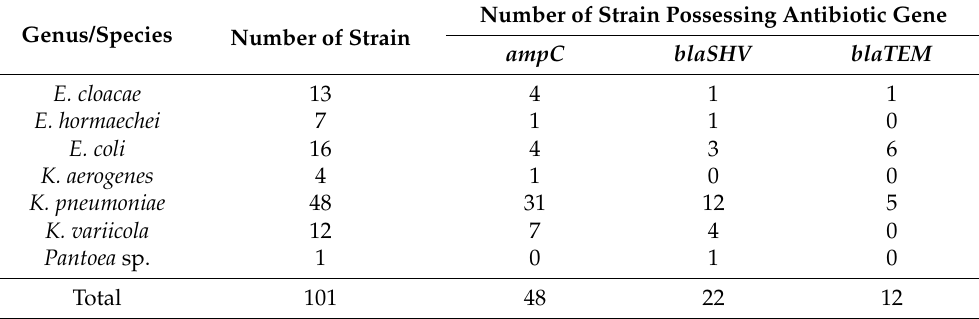
Table 4. Number of enterobacterial strain in each genus or species that possessed antibiotic